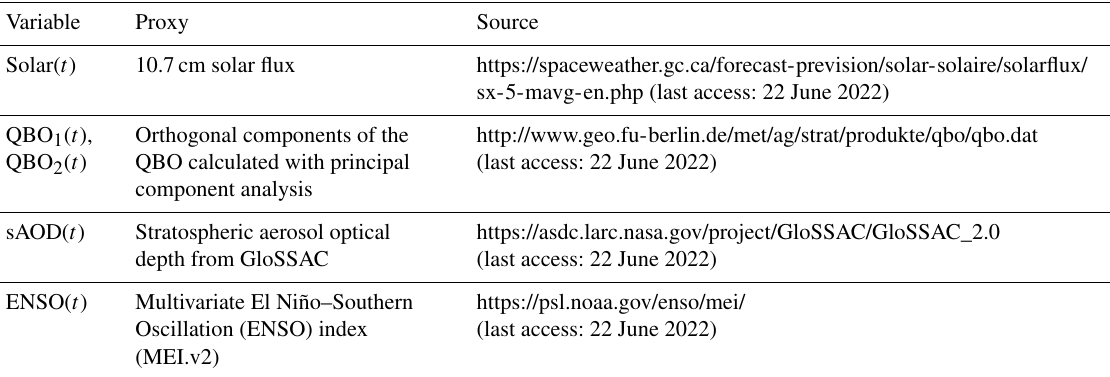
Table 2. Sources of explanatory variables and proxy time series used in the LOTUS regression model.